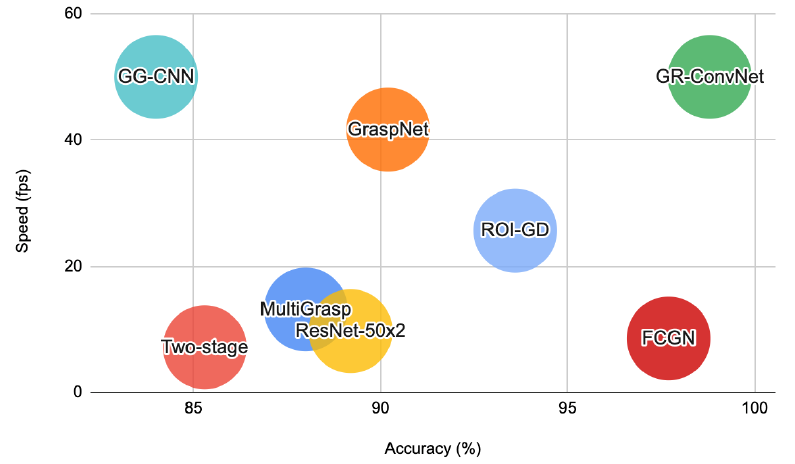
Figure 2. Performance comparison of GR-ConvNet on Cornell Grasping Dataset with prior